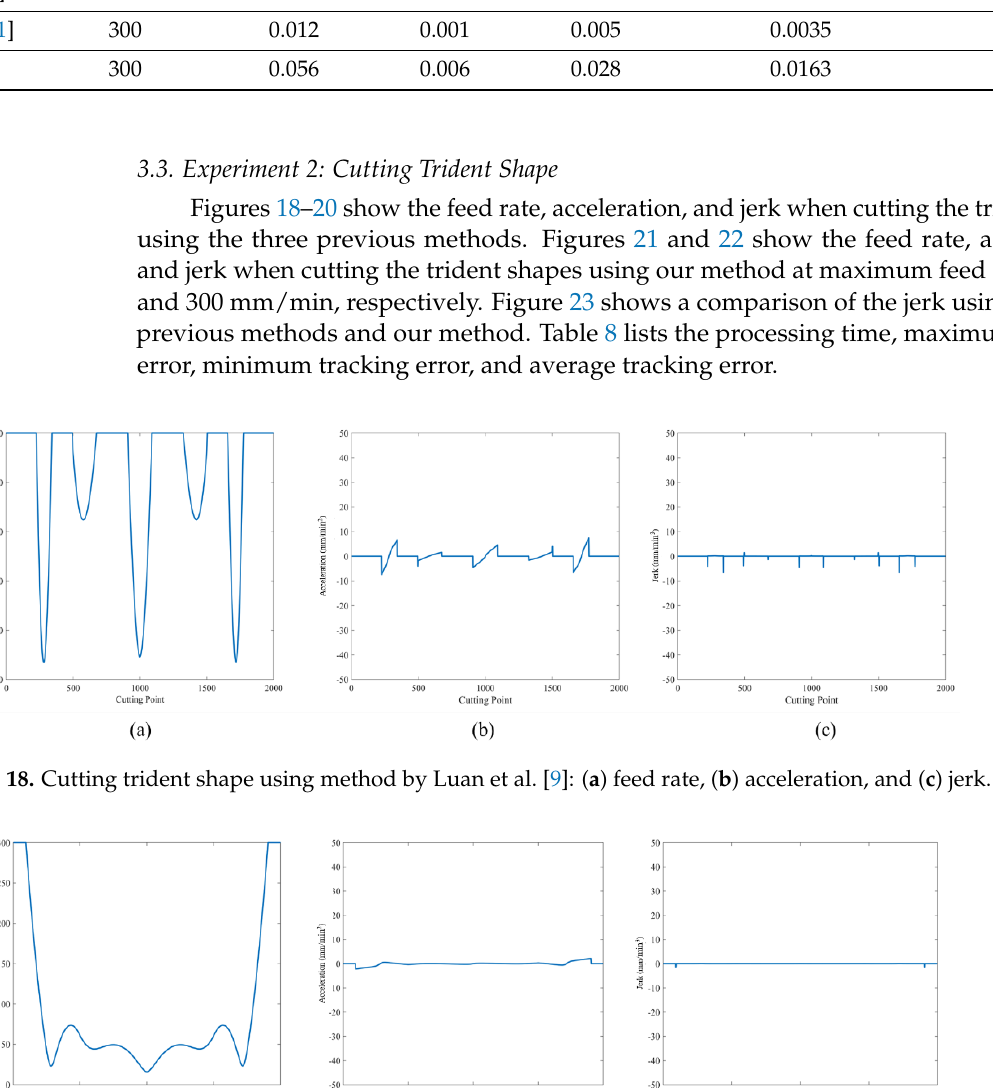
Figure 21. Cutting trident shape using our method with maximum feed rate of 150 mm/min: ( a ) feed rate, ( b ) acceleration, and ( c ) jerk. Figure 22. Cutting trident shape using our method with maximum feed rate of 300 mm/min: ( a ) feed rate, ( b ) acceleration, and ( c ) jerk. Table 8. Tracking error and processing time for trident shape. Max Speed